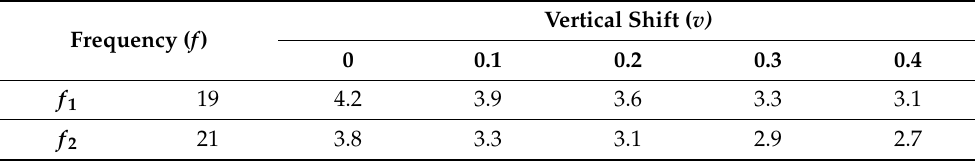
Table 4. Distance between bars (filled sections with 3D printed material) in millimeters (q).